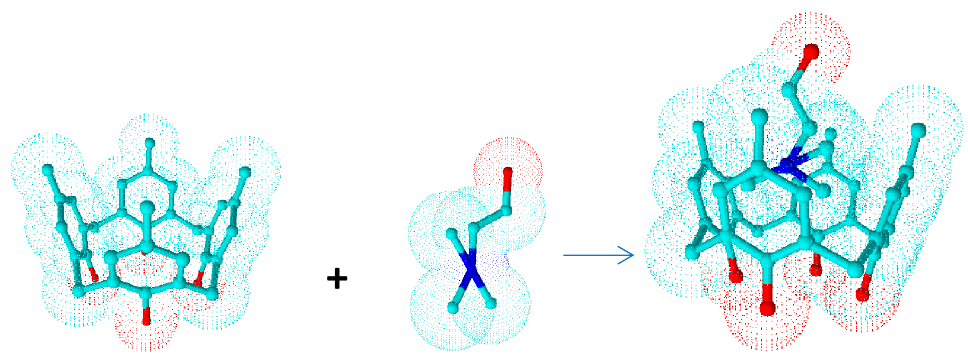
+ Figure 5. Three-dimensional representation of the complexation process of Figure 5. Three-dimensional representation of the complexation process of calix[4]arenes.